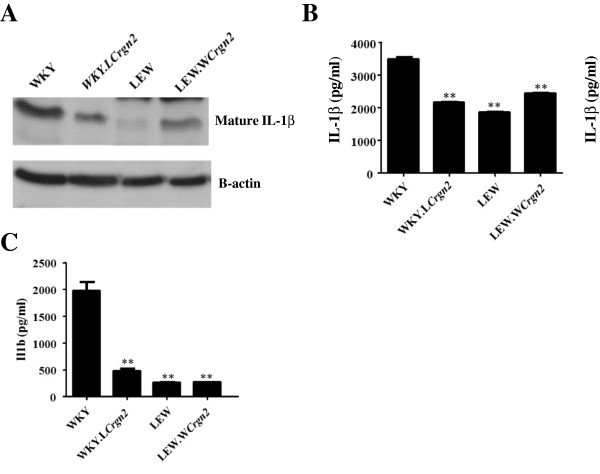
JunD expression levels control the production of mature IL-1β in BMDMs and nephritic glomeruli. (A) Western blot of mature IL-1β expression in WKY, WKY.LCrgn2, LEW and LEW.WCrgn2 BMDMs primed with LPS and stimulated with ATP. The result of 3 independent experiments is demonstrated alongside β-actin loading control. ELISAs for IL-1β in LPS primed and ATP activated BMDMs (B) and in nephritic glomeruli (C). **P<0.01 statistically significantly different to WKY using a one way-ANOVA with Bonferonni’s post-tests.